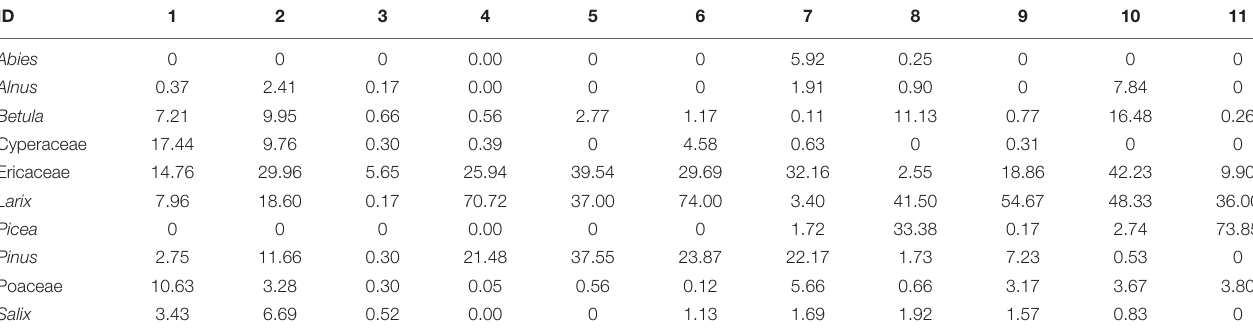
TABLE 3 | Land-cover types from Sentinel-2 data and their major taxa composition in this study. ID